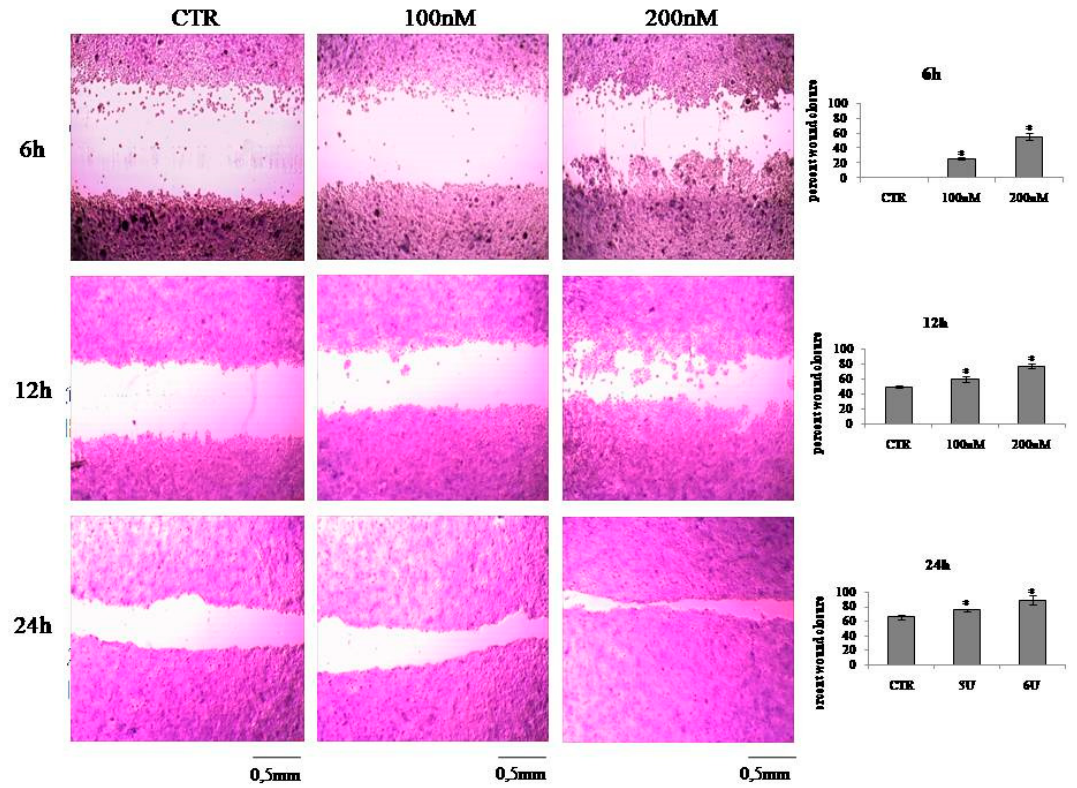
Figure 3. E ff ect of VD3 in wound closure. HaCaT cells were treated with 100 and 200 nM VD3, and wound healing assay was performed after 6, 12, and 24 h. The left figure is the panel of microscopy images, and the right figure shows the percentage of closure. Data are expressed as mean ± SD of three independent experiments performed in duplicate. Significance, * p < 0.001 versus control sample.